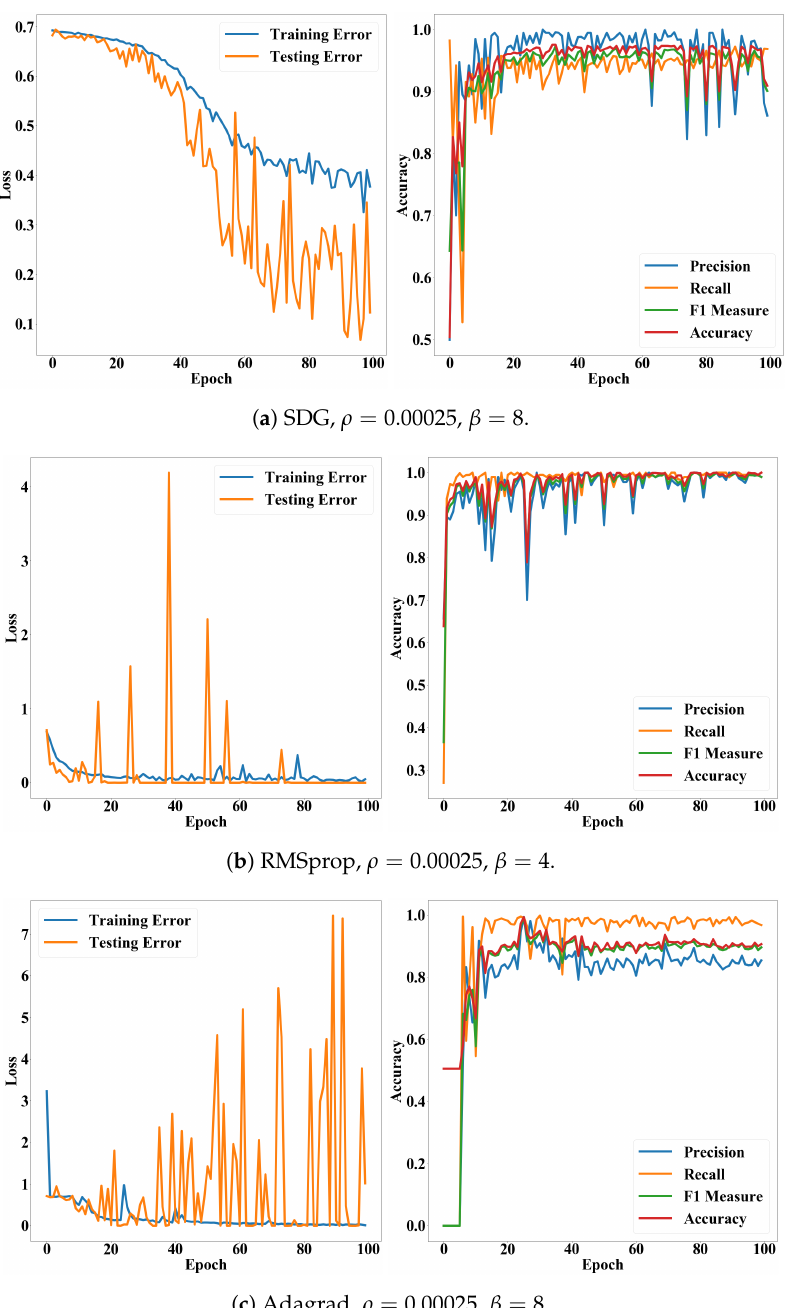
Figure 8. Loss and accuracy of the CNN model according to epochs. ( a – c ) present accuracy and loss of the SDG, RMSprop, and Adagrad on their optimal hyper-parameters,